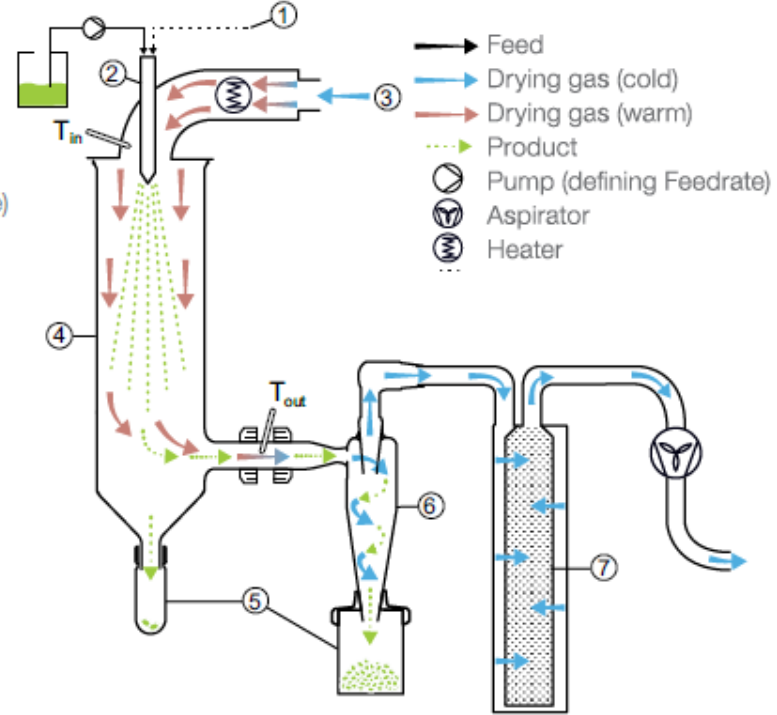
Figure 2. Schematic representation of spray drying instrument. BUCHI Labortechnik AG [31].